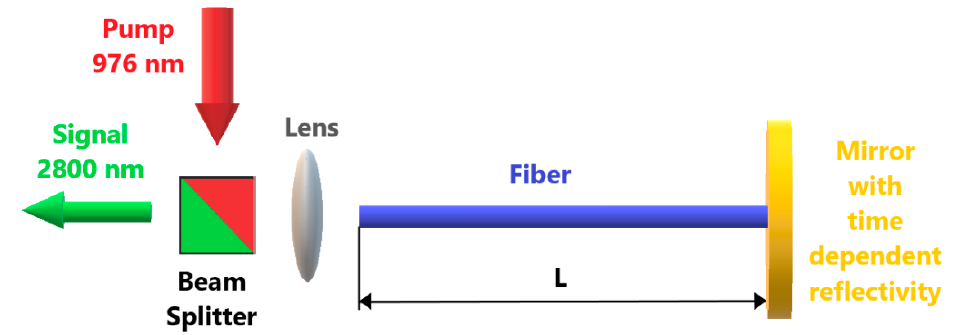
Figure 1. Schematic diagram of the Q-switched fiber laser cavity.